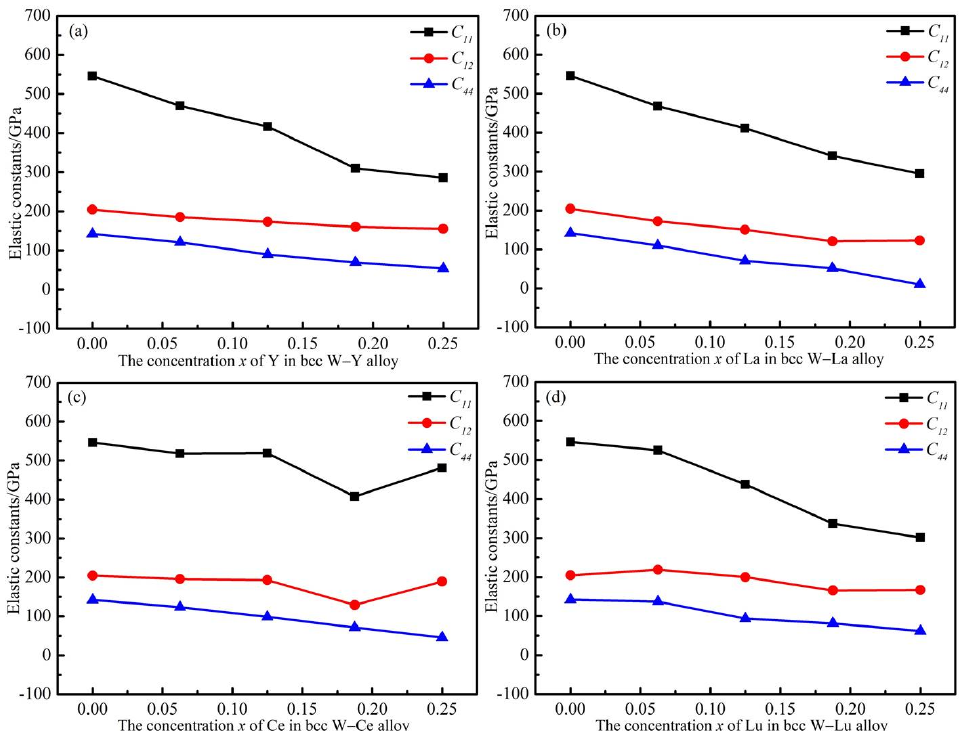
Figure 5. Three elastic constants of W–M binary alloys as functions of M concentration. ( a – d ) reresent W–Y, W–La, W–Ce, and W–Lu binary alloy system, respectively.